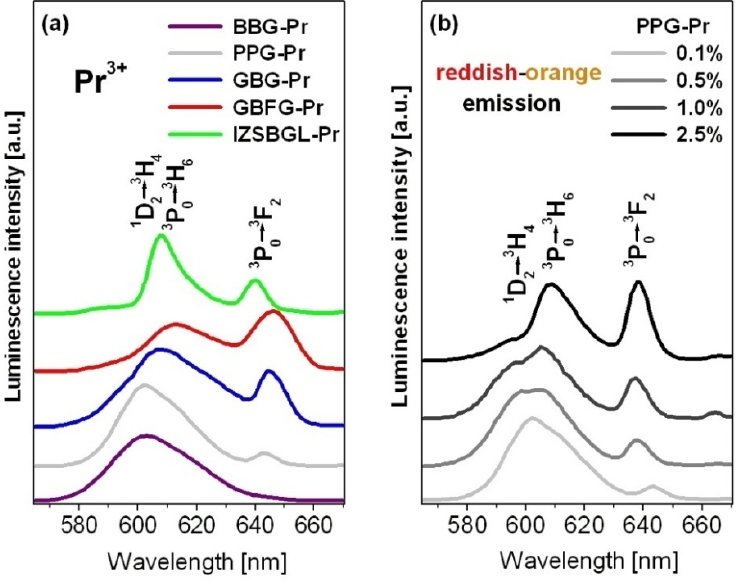
Figure 5. Reddish orange emission as a function of glass-host ( a ) and Pr 3+ concentration ( b ).